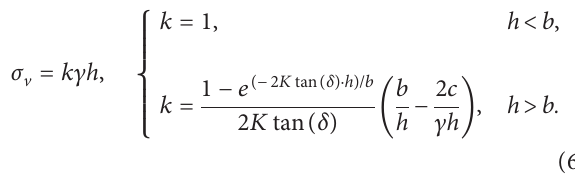
Figure 2: Boundary planes of wedge failure. Terzaghi and Terzaghi/ Houska silo